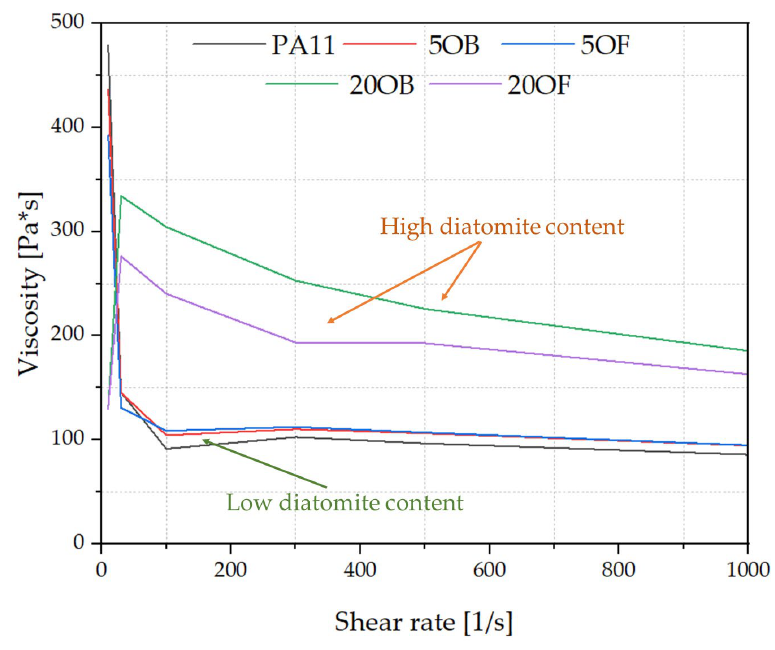
Figure 8. The viscosity of biocomposites of PA11 and diatoms after the injection (capillary